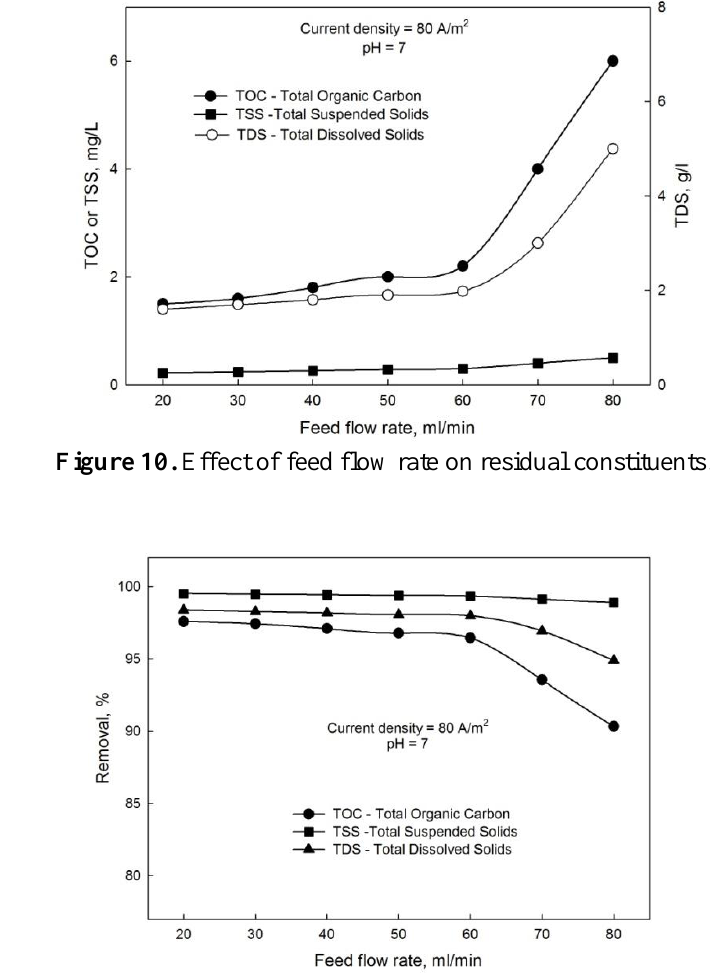
Figure 11. Effect of feed flow rate on removal